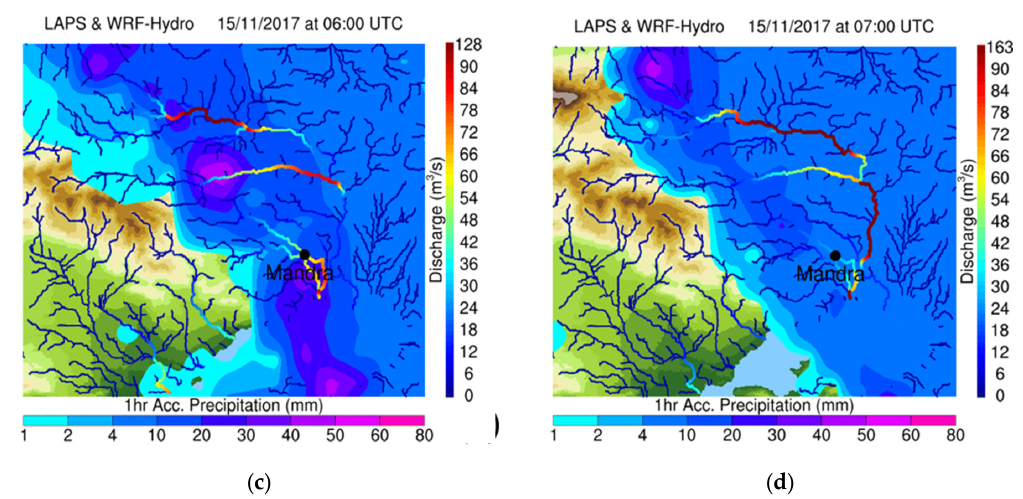
Figure 6. One hour accumulated precipitation superimposed with the simulated discharges forced by the LAPS nowcasts. WRF-Hydro simulation starting on 15 November at 03:00 UTC and going up to 07:00 UTC every hour ( a – d ), forced by LAPS nowcasts from 04:00 to 07:00 UTC. Streams with order 4 or higher are presented.